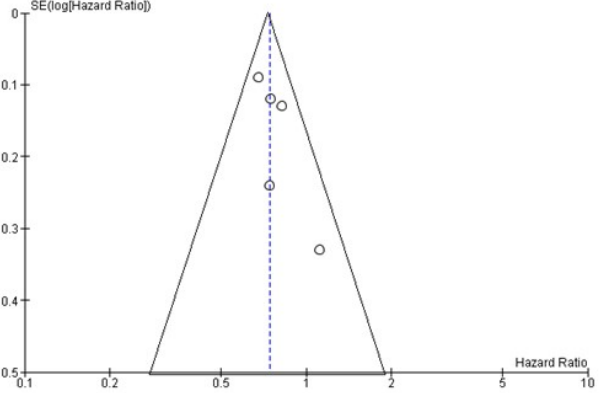
Figure 5. Forest plot of adverse events obtained using fixed effects.